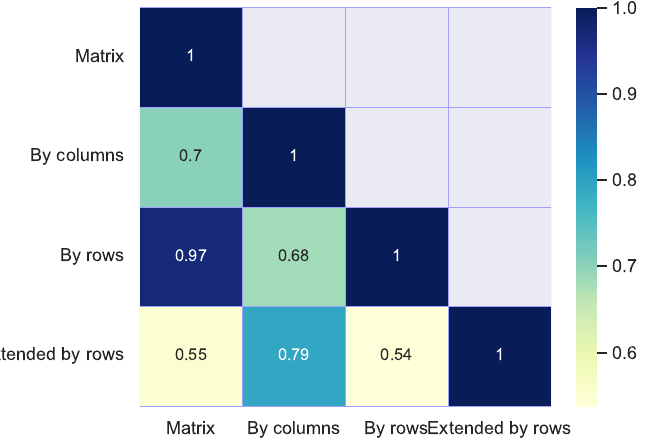
Figure 5. Heatmap of classification coincidences for different standardizations.